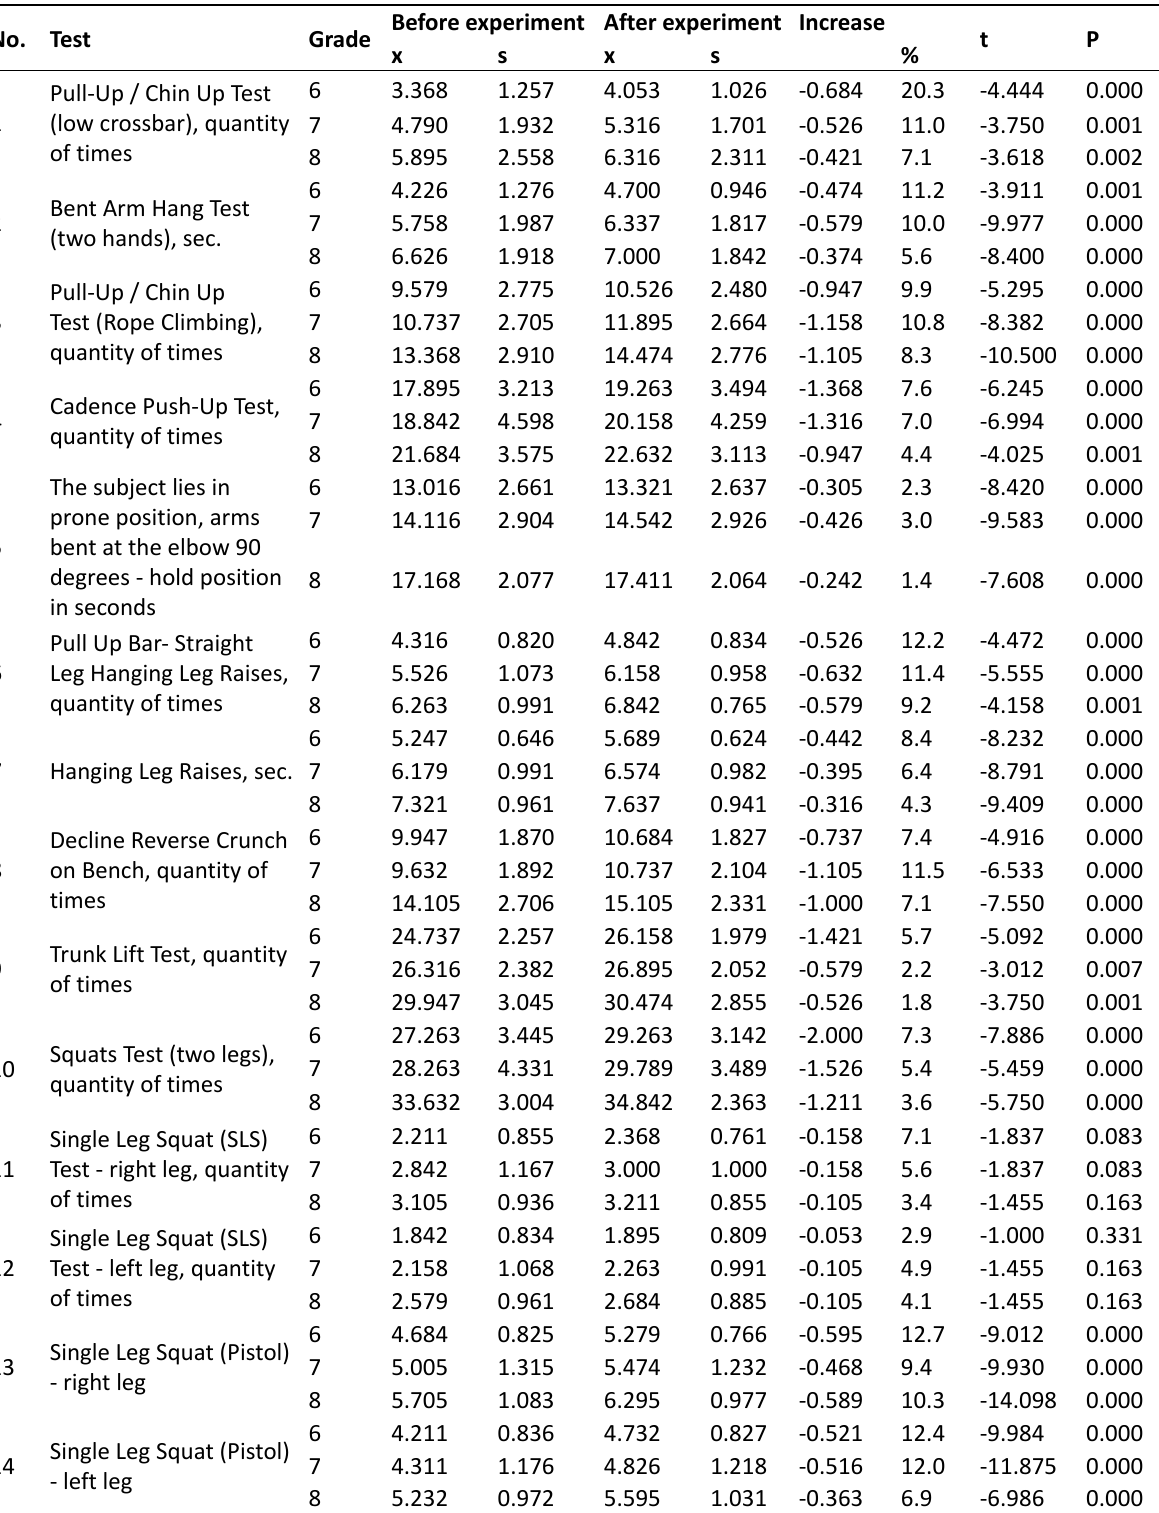
Table 1. T est results of strength fitness of 6 th -8 th grade boys (experimental group). Combined method of